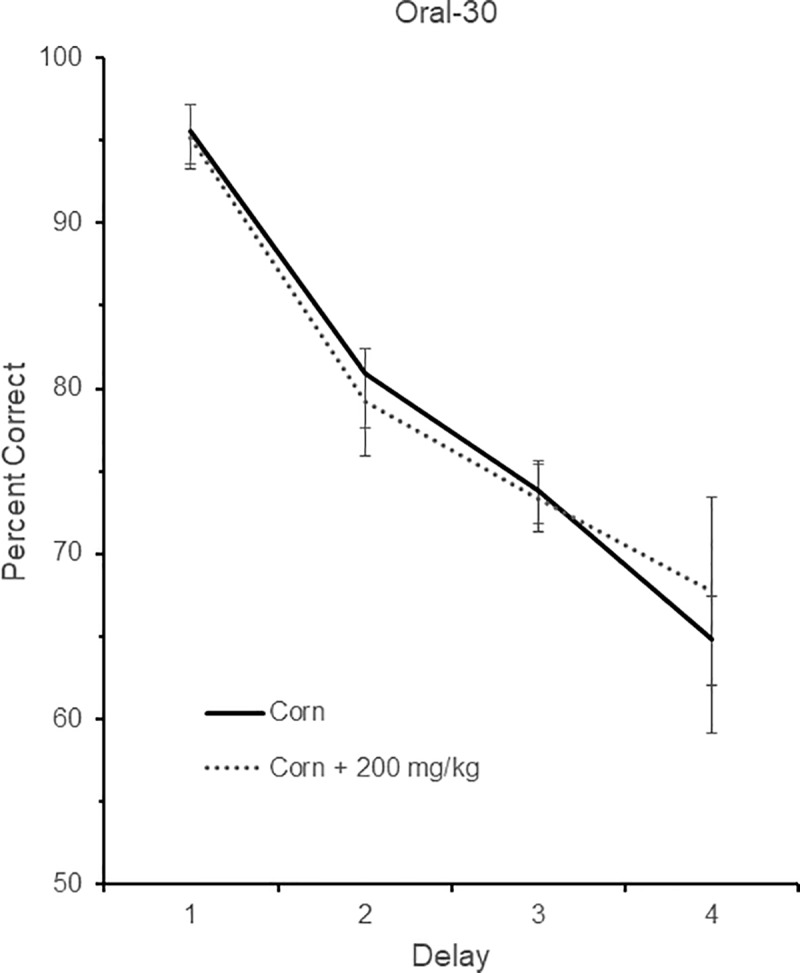
DMS performance in the Oral-30 condition.DMS performance following no drug (corn) or drug (corn + 200 mg/kg aniracetam in the Oral-30 condition. A total of five birds were tested. One bird was tested on delays of 0, 1, 2, and 4 sec (Delay set 1), one was tested on delays of 0, 2, 4, and 8 sec (Delay set 2), two were tested on delays of 0, 3, 6, and 9 sec (Delay set 3), and one was tested on delays of 0, 5, 10, and 20 sec (Delays set 5). Chance is 50% correct. Error bars are +/- SEM.